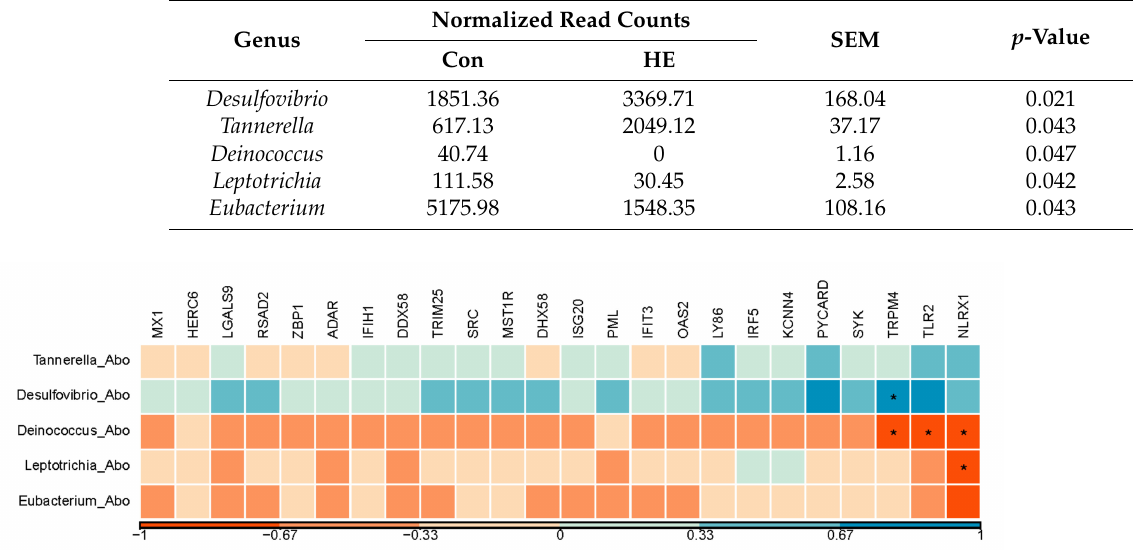
Table 1. The active bacteria changes in abomasum identified by rRNA transcriptome analysis. HE: